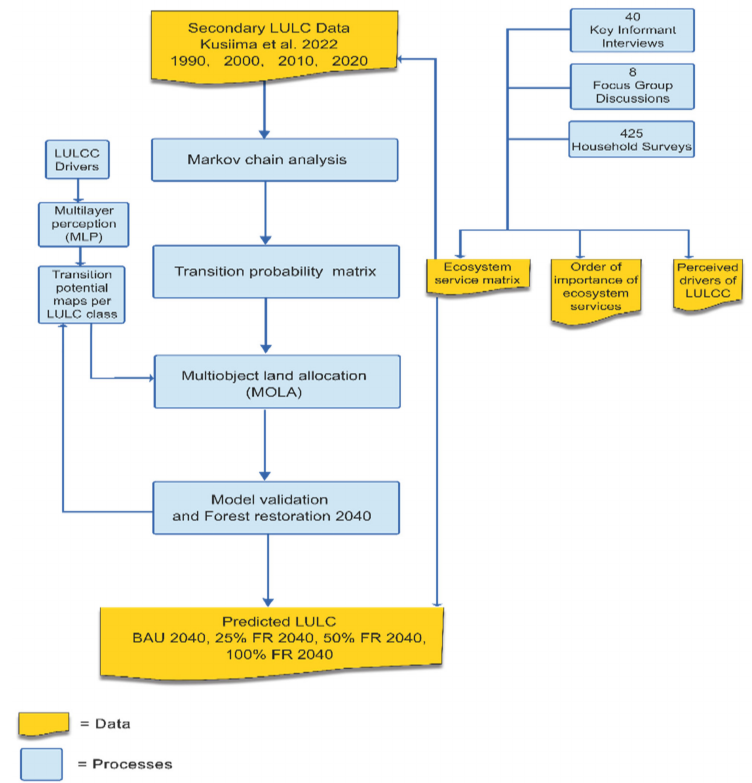
Figure 2. Schematic diagram of the research methods used in the study [46].